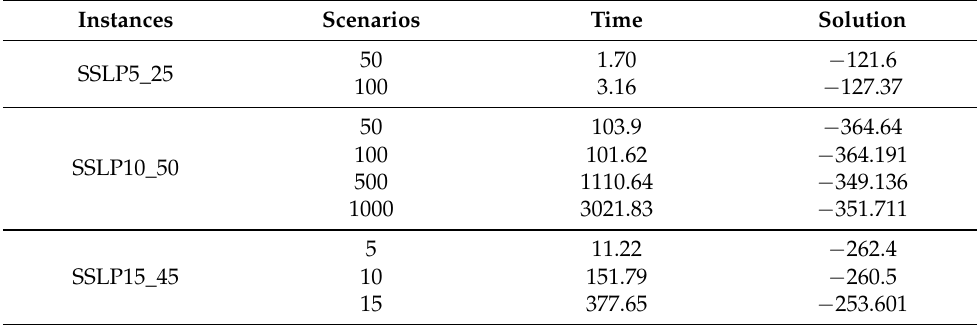
Table 3. Results of DSP with DW-based branch-and-bound on SSLP instances.